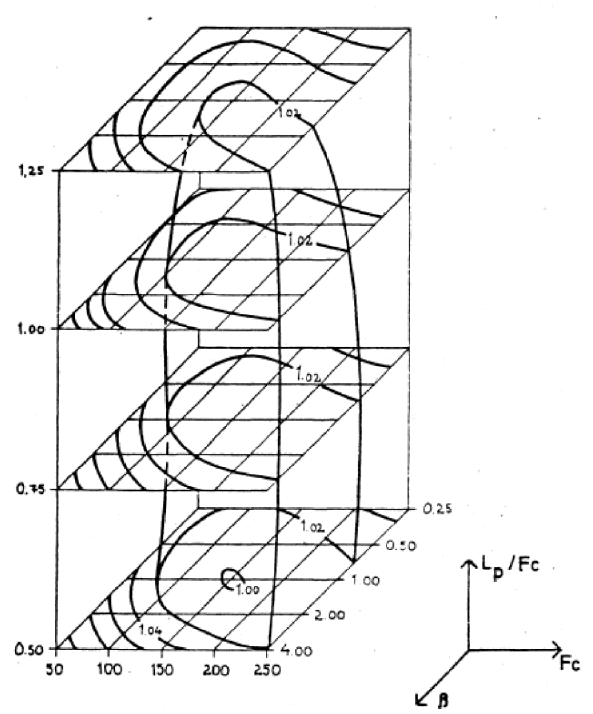
Figure 3. Mapping of the error function around the optimum val- ues of the three parameters in the soil moisture routine of the HBV model when applied to the Filefjell research basin in Norway. Hand- made drawing based on 100 model runs from Bergström